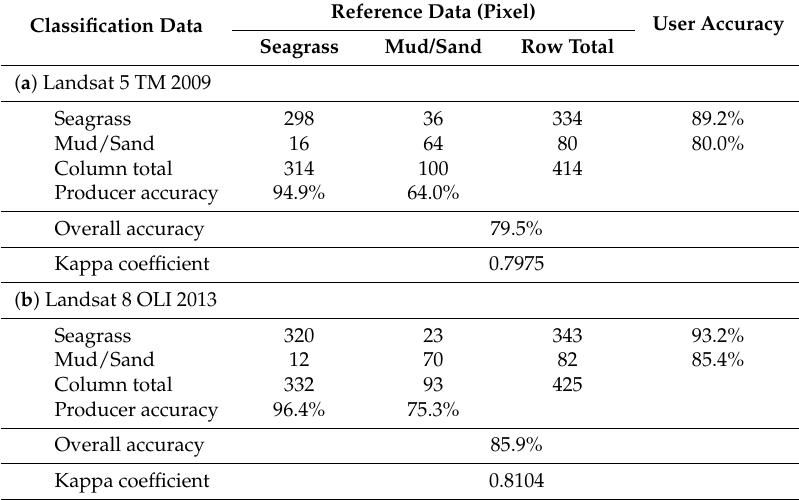
Table 6. Confusion matrix of classification on coastal features using bottom reflectance index BRI on ( a ) Landsat 2009 and ( b ) 2013 by maximum likelihood classifier (MLC). A set of training samples of each class from in situ data has been assigned to classify the BRI